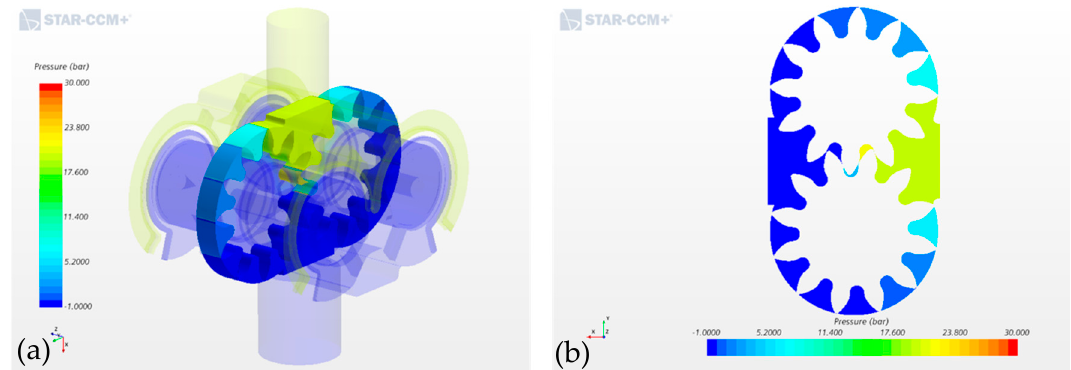
Figure 14. Pressure colored maps: ( a ) Pressure distribution within the entire 3D fluid domain of the pump; ( b ) section view of the pressure field in the gears’ region.